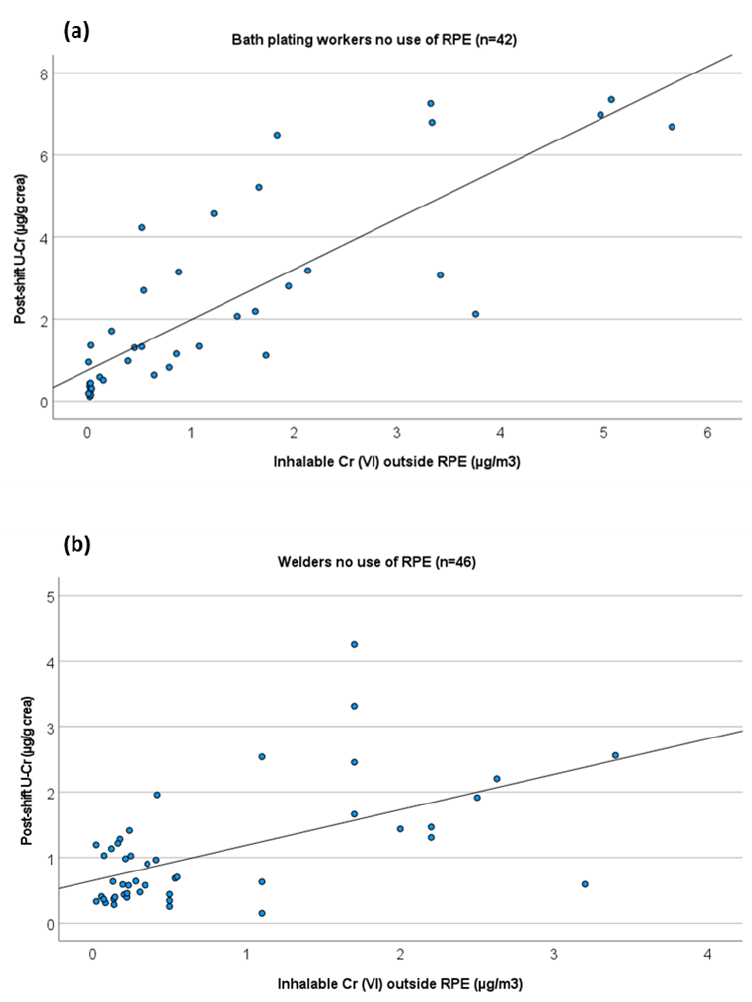
Figure 2. Regression analyses showing the relationship between U-Cr levels and inhalable Cr(VI) levels for ( a ) bath platers (y = 0.742 + 1.235x, r s = 0.858, R 2 = 0.679) and for ( b ) welders who did not